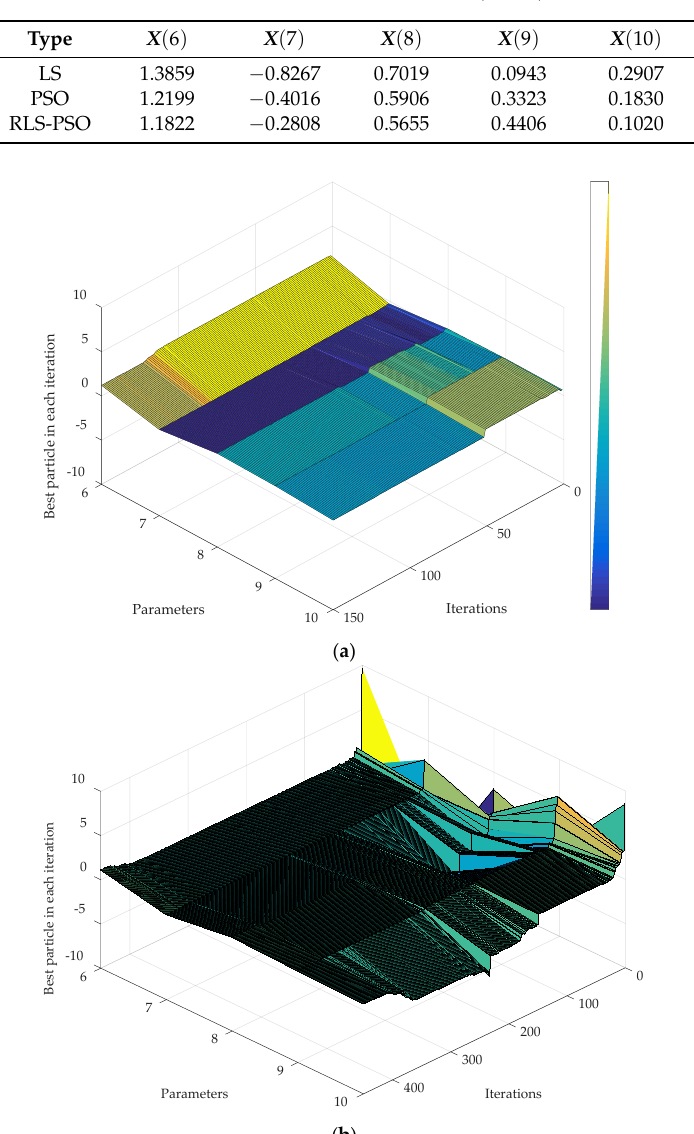
Figure 8. The convergences of X (6:10) in PSO and RLS-PSO: ( a ) The convergence of best particle in RLS-PSO’s iterations; ( b ) The convergence of best particle in PSO’s iterations. Trajectory 2 was the reference group, and the identification values of (6:10) X was quantified by the quantitative evaluation method in Figure 7. Figure 9 is a comparison of the identified torque, the measured torque, and the torque error T . error The absolute values of T were averaged. The mean ± std of the absolute torque error of LS error as shown in Figure 10 is 1.0427 ± 0.9047 Nm. The mean ± std of the absolute torque error of the PSO is 0.5126 ± 0.4386 Nm. The mean ± std of the absolute torque error of the RLS-PSO is 0.1887 ± 0.2475 Nm. As shown in Figure 10, it is clear that the most accurate